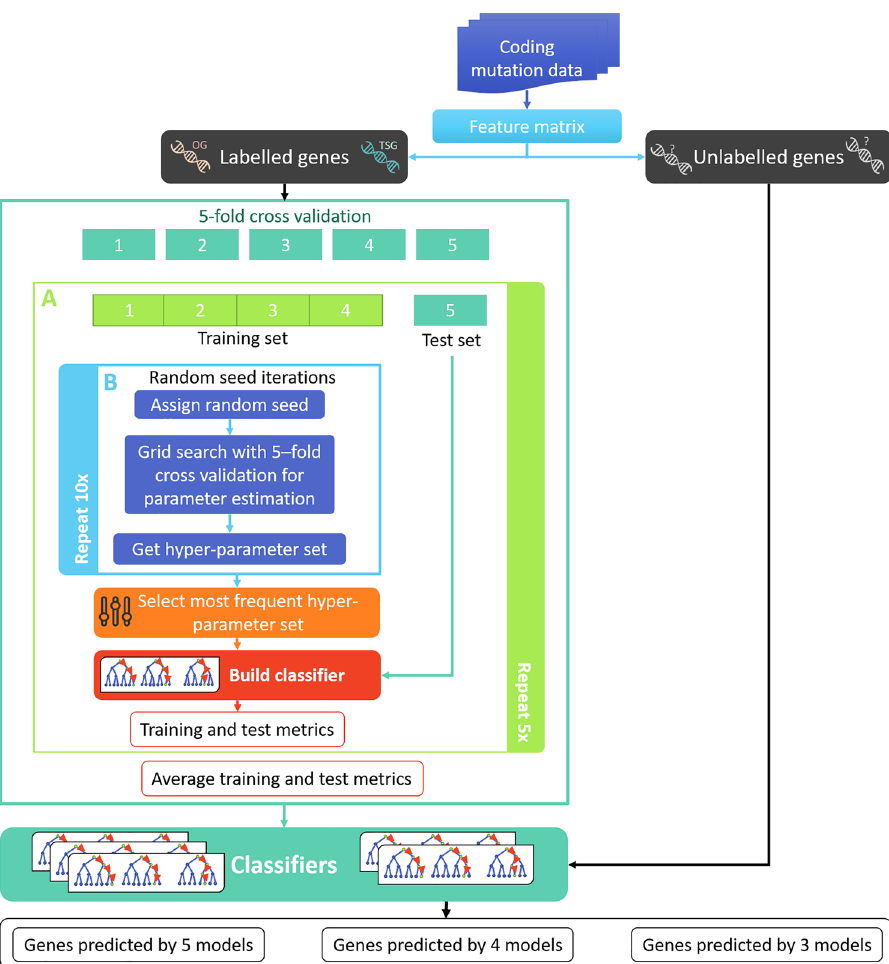
Figure 1. Methodology for identifying new driver genes. The figure presents an overview of the different steps involved in our study as described in “Outline of cTaG” section. The somatic mutation data is used to generate the feature matrix where the rows and columns represent genes and features respectively. The genes labelled as TSG or OG were used for building the models. Block A (light green frame) shows how classifier is built and is repeated five times for each fold (details in “Classification of genes” section). Block B (light blue frame) shows random iterations for estimation of hyper-parameters and is repeated 10 times to identify a set of stable hyper- parameters (details in “Tuning hyperparameters” section). The five models are then used to make predictions on unlabelled genes to identify the new driver